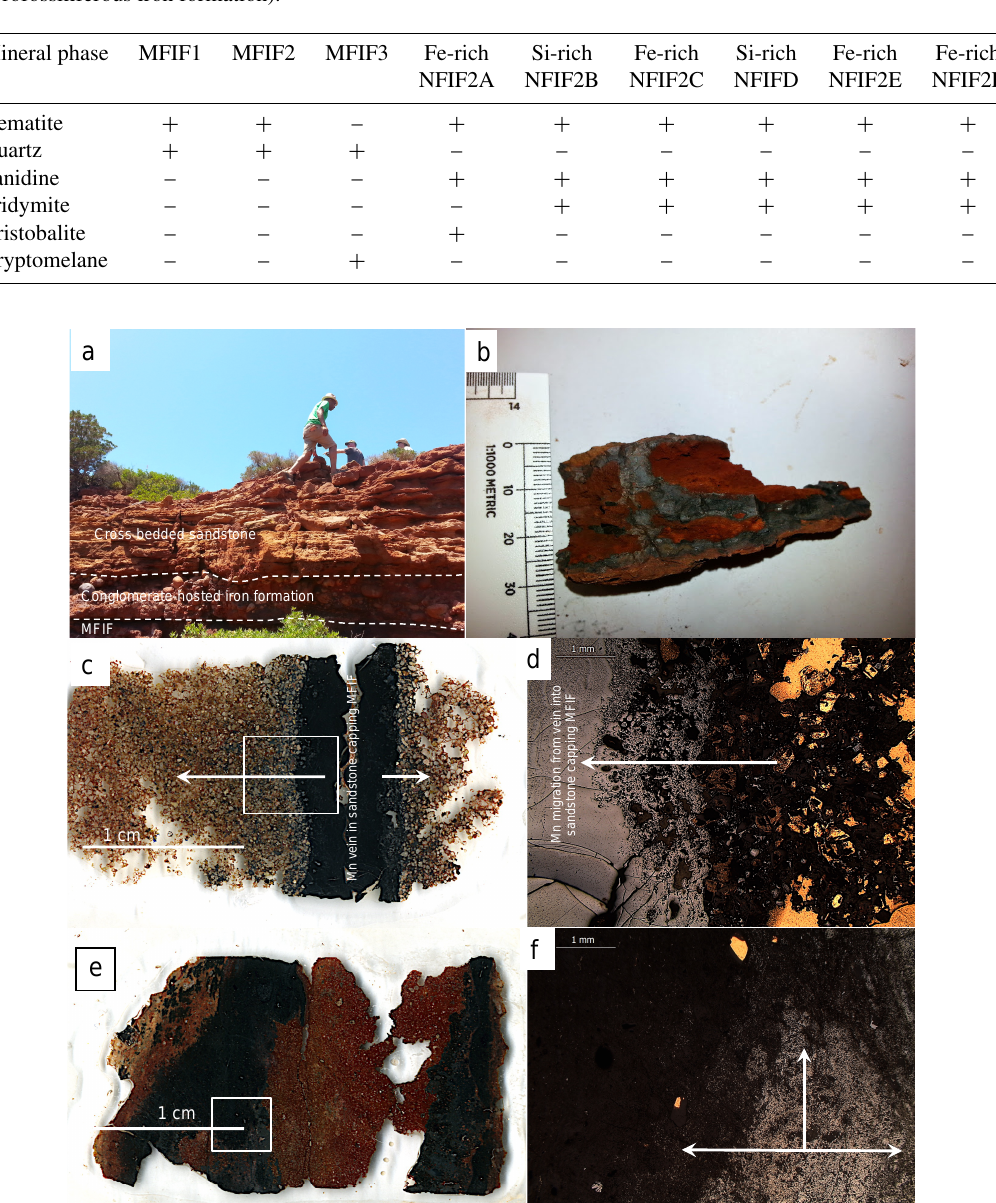
Figure 4. Sedimentary profile, thin section scans and optical microscope images of the MFIF. (a) Field photo showing the sedimentary profile of the MFIF characterized by the overlying sandstone cap. (b) Photograph showing black diffused Mn-rich bands near the base of the MFIF. (c) Scanned image of thin section showing a black Mn-rich vein in the overlying MFIF sandstone showing a gradient of Mn migrating into the sandstone matrix (white arrows). (d) Light microscopy images showing details in panel c . (e) Scanned image of an MFIF thin section showing black Mn band migration into a red iron-rich background. (f) Amplified light microscope image showing gray Mn layers migrating into a black Fe-rich matrix. White arrows show direction of movement. Boxes in (c) and (e) are amplified in (d) and (f)